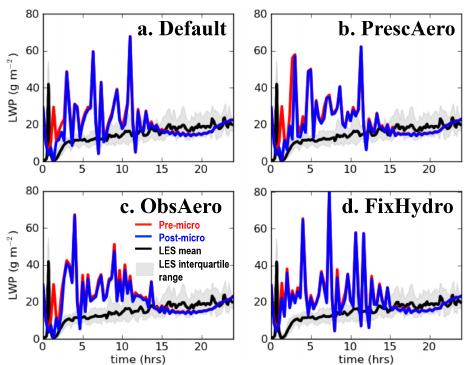
Figure 6. Time series of LWP during the RICO intensive observa- tion period (IOP) period. LES data come from